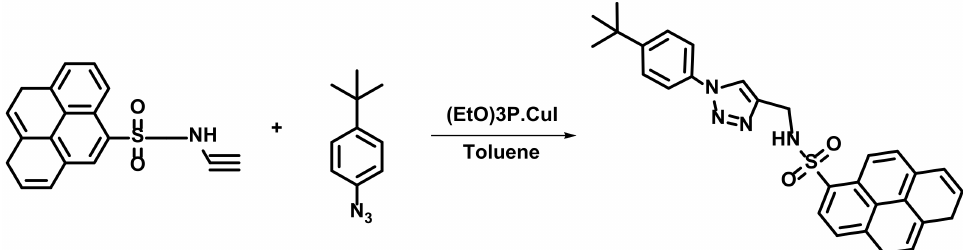
Figure 15. Synthetic route for obtaining a novel pyrenyl-appended triazole system for the detection of Hg 2+ ions. Repro- duced with permission from [38] by Elsevier.